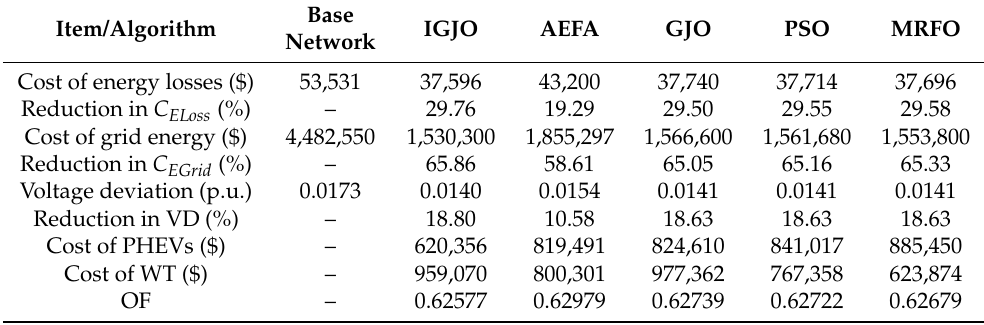
Table 4. The results of WT and PHEV scheduling in the distribution network using different algorithms.